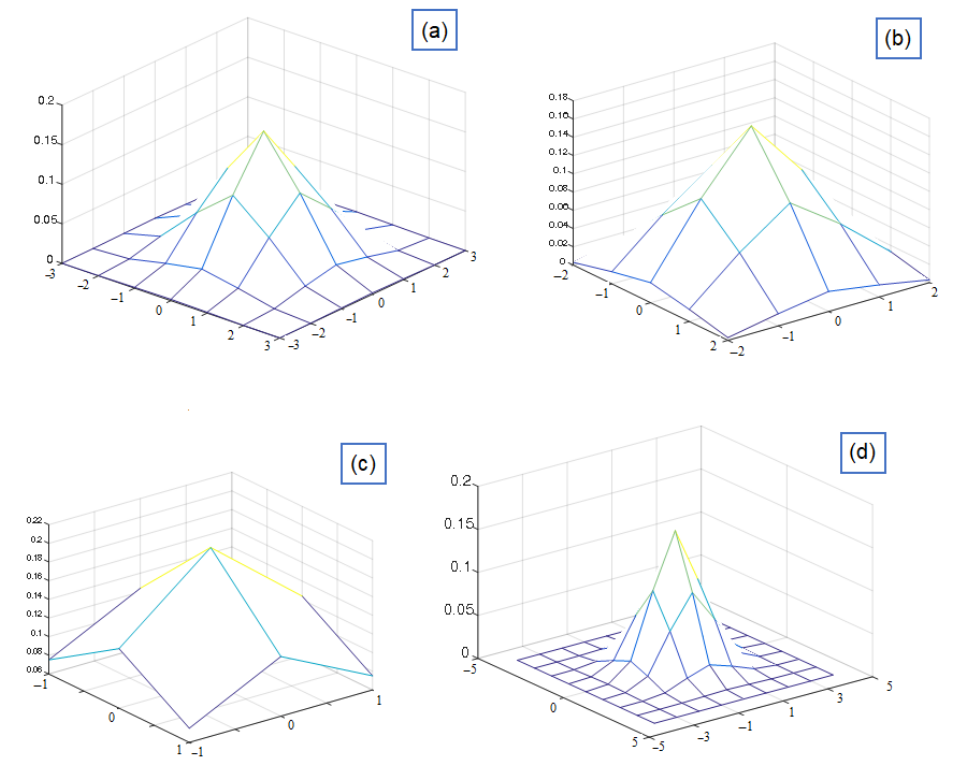
7 ( b ) 5 5 ( c ) 3 3 ( d ) 9 × × × ×